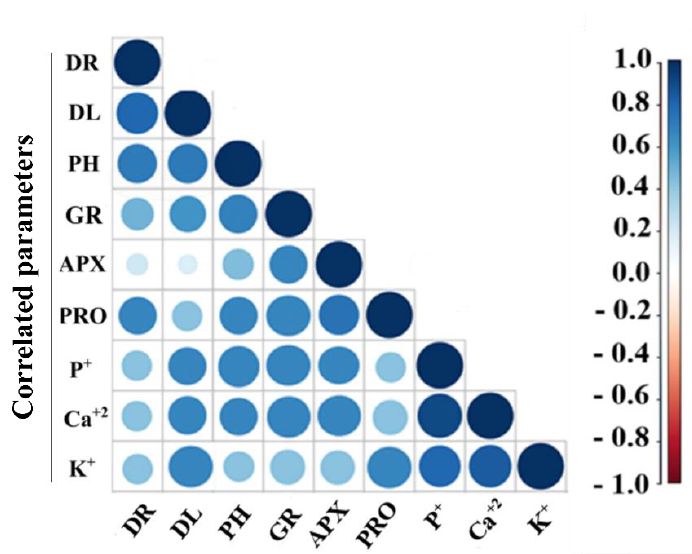
Figure 4. Pearson’s correlation matrix between plant growth, antioxidant enzymes, proline accumulation and nutrient uptake in plants inoculated with Bacillus spp. after 33 days of drought stress. Correlations are displayed in blue (positive) and red (negative); color intensity and circle size are proportional to the correlation coefficient. DR: dry root biomass, DL: dry leaf biomass, PH: plant height, GR: glutathione reductase activity, APX: ascorbate peroxidase activity, PRO: proline accumulation in plant tissue, P + : phosphorous concentration in plant tissue, Ca +2 : calcium concentration in plant tissue, and K + : potassium concentration in plant tissue.